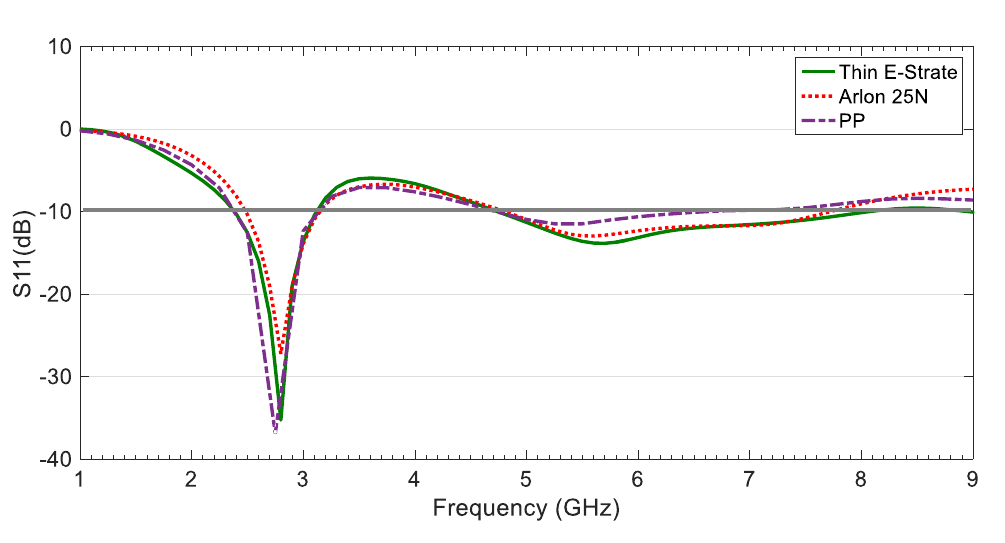
Figure 3. Return loss simulation results for the CPW-fed slot monopole antenna based on ENrG’s Thin E-Strate, Arlon 25N, and polypropylene (PP) substrates.